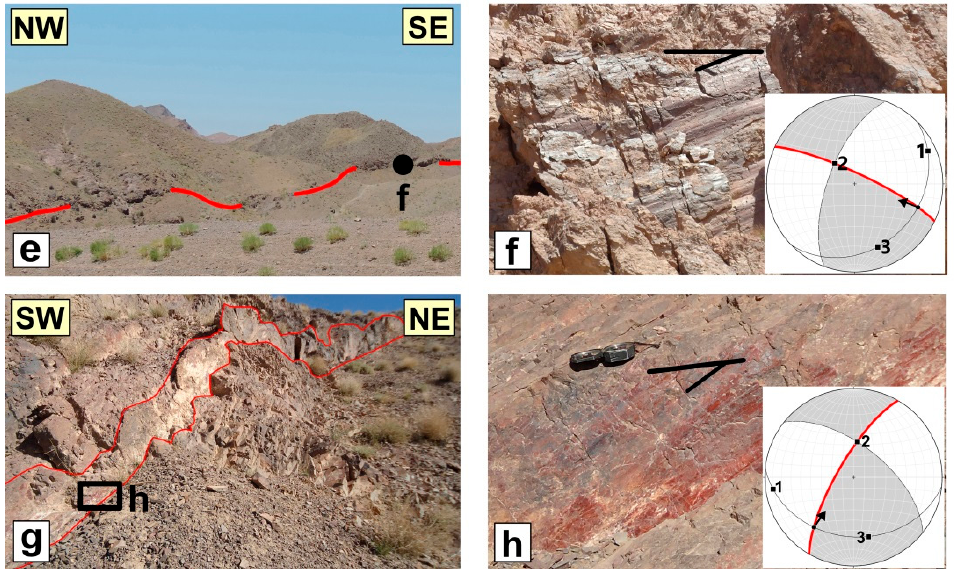
Figure 13. Field images of the roof faults ( a , b ) and ramps ( c – f ) of the duplex, and also the antithetic fault ( g , h ) in the Shekarab shear zone. ( a ) The left-lateral displacement of the rock units along the roof fault. ( b ) The repetition of the rock units by the roof fault. ( c ) The reversed rock units of H2 on the H1. ( d ) ~350 m left-lateral offset of the rock units along the ramp (2). ( e , f ) The surface trace and close-up view of the R3 (N65°W, 80°NE; 110°/25°). ( g , h ) The surface trace and close-up view of the antithetic fault (N30°E, 75°NW; 218°/29°).